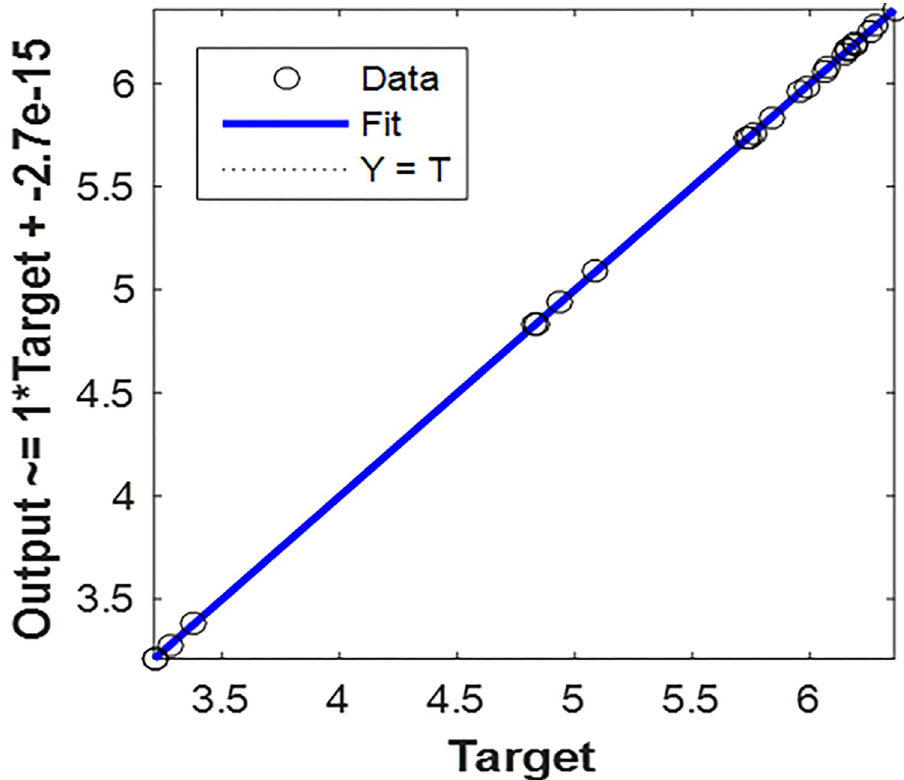
Fig 12. Cross-correlation using scatter plot (1:1 correspondence, X = Y) of predicted and actual wheat grain (Mg ha -1 ) using Levenberg Marquardt (LM) algorithm in artificial neural networks